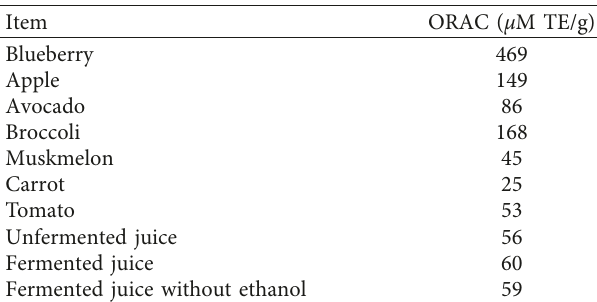
Table 2: ORAC values of some